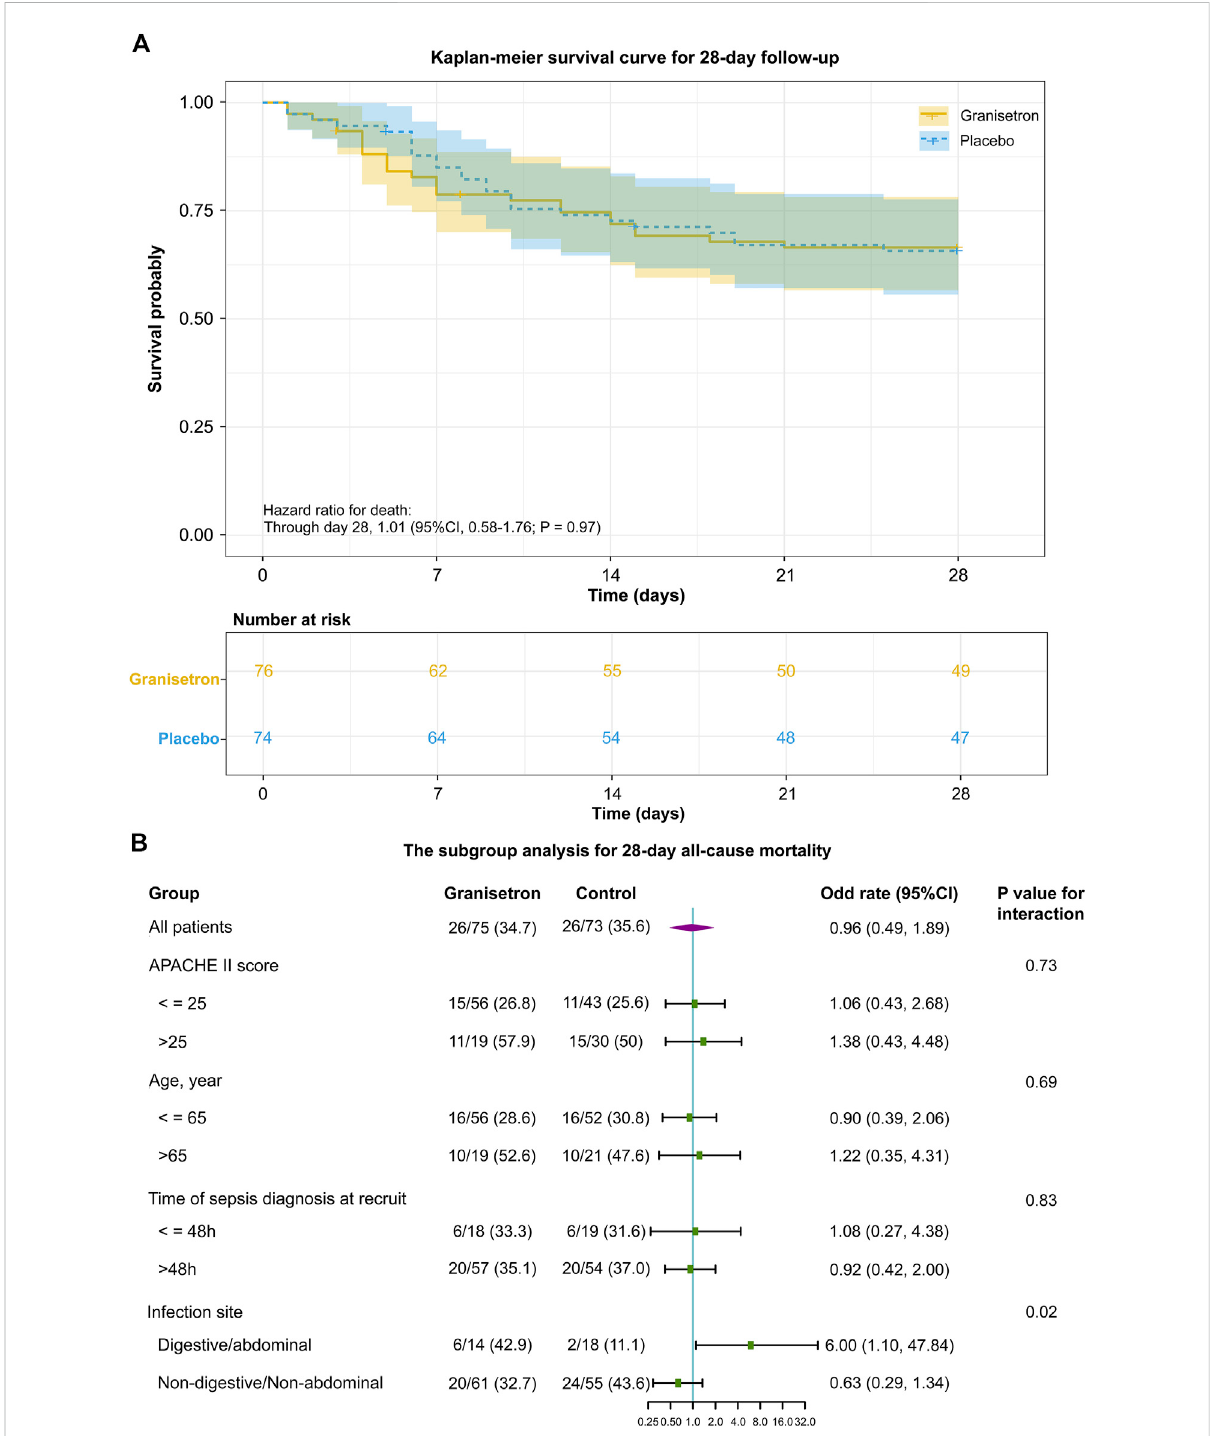
FIGURE 2 The primary outcome of granisetron therapy in all patients or in patients of the different subgroup (A) Kaplan – Meier survival curve during the 28dayfollow-up.Inthesurvivalanalysis,150patientswereincluded.Thedateofmortalityfortwopatientswithin28 dayswasnotavailable,soitwas censored. The tick marks indicate censored data.The p -value was calculated using aCox proportional hazards model that included the randomized trialgroup. (B) Thesubgroupanalysisfor28 dayall-causemortality.Thevariablesofthesubgroupanalysis,oddrate,95%CIineachcomparison, the number of patients (denominator), the number of deaths (numerator) in each subgroup, and the p -value of interaction between the groups (granisetron or placebo) and the grouped variables (APACHE II score or Age or Time of sepsis diagnosis at recruit or Infection site) are